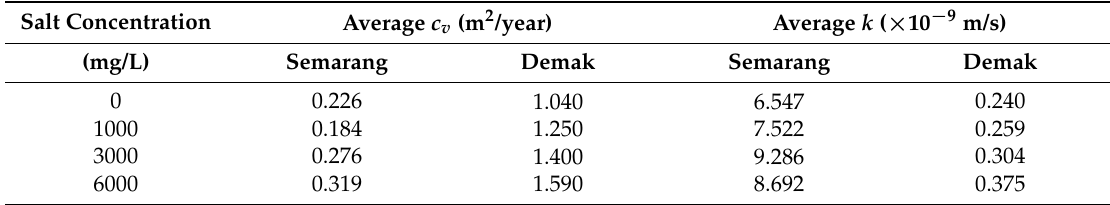
Table 3. Average coefficient of consolidation ( c v ) and hydraulic conductivity ( k ) of Semarang-Demak